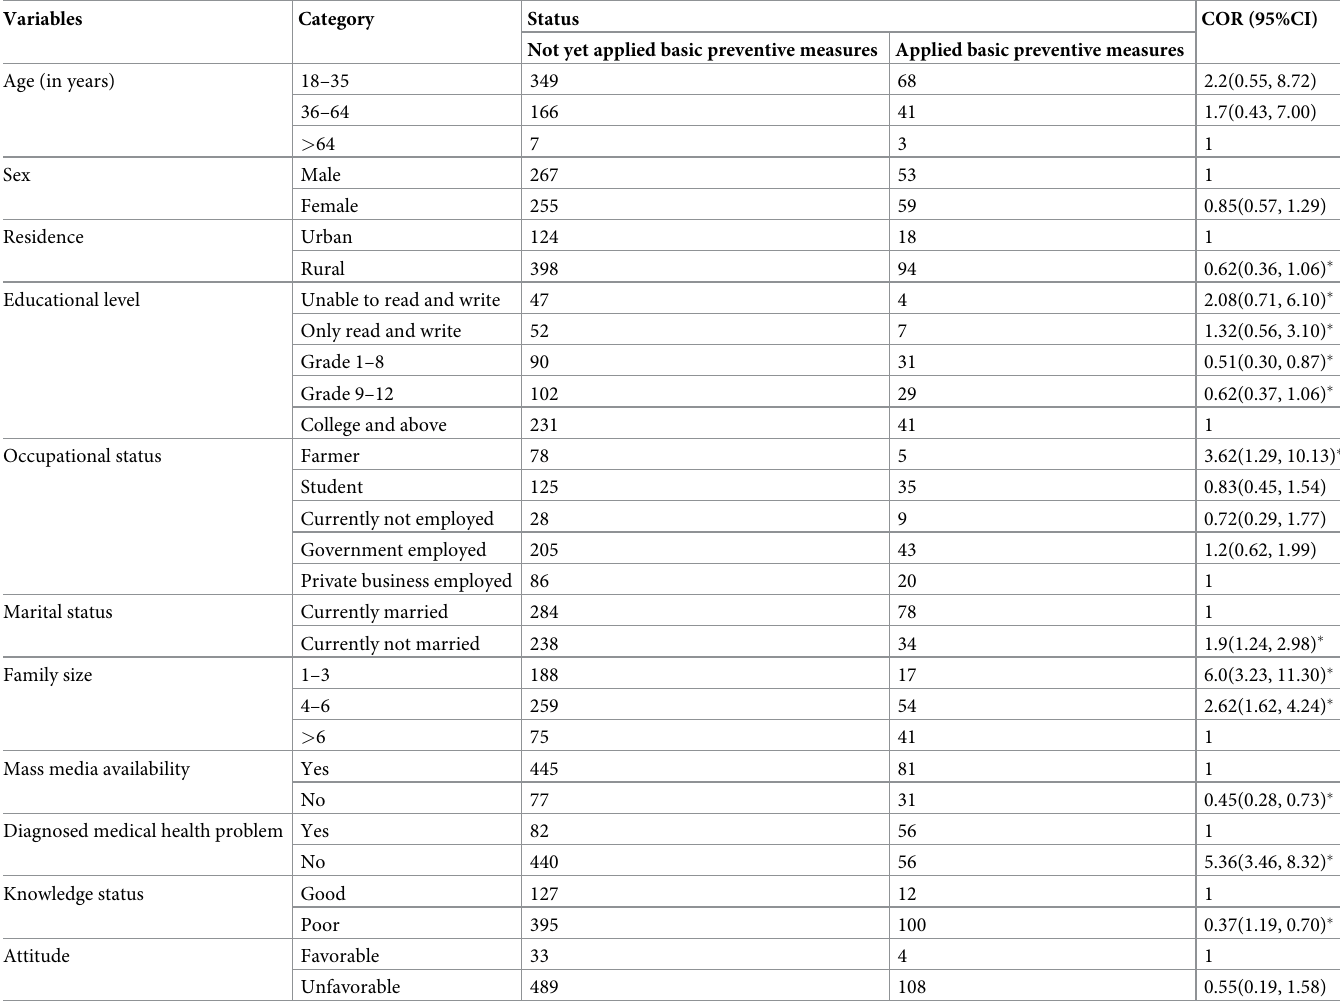
Table 5. Bivariable analysis of factors associated with the applicability of the basic preventive measures of the pandemic COVID-19 among residents in Guraghe Zone, 2020 (n =